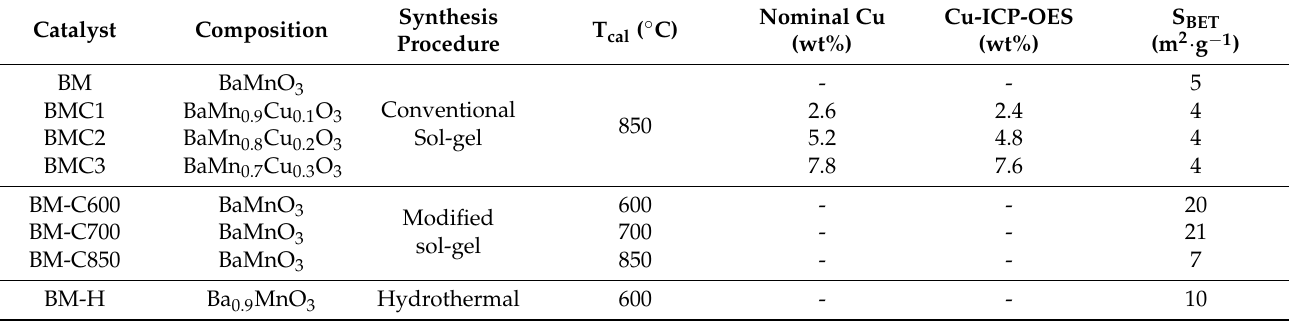
Table 1. Chemical composition, copper content by ICP-OES and BET surface area of the catalysts.